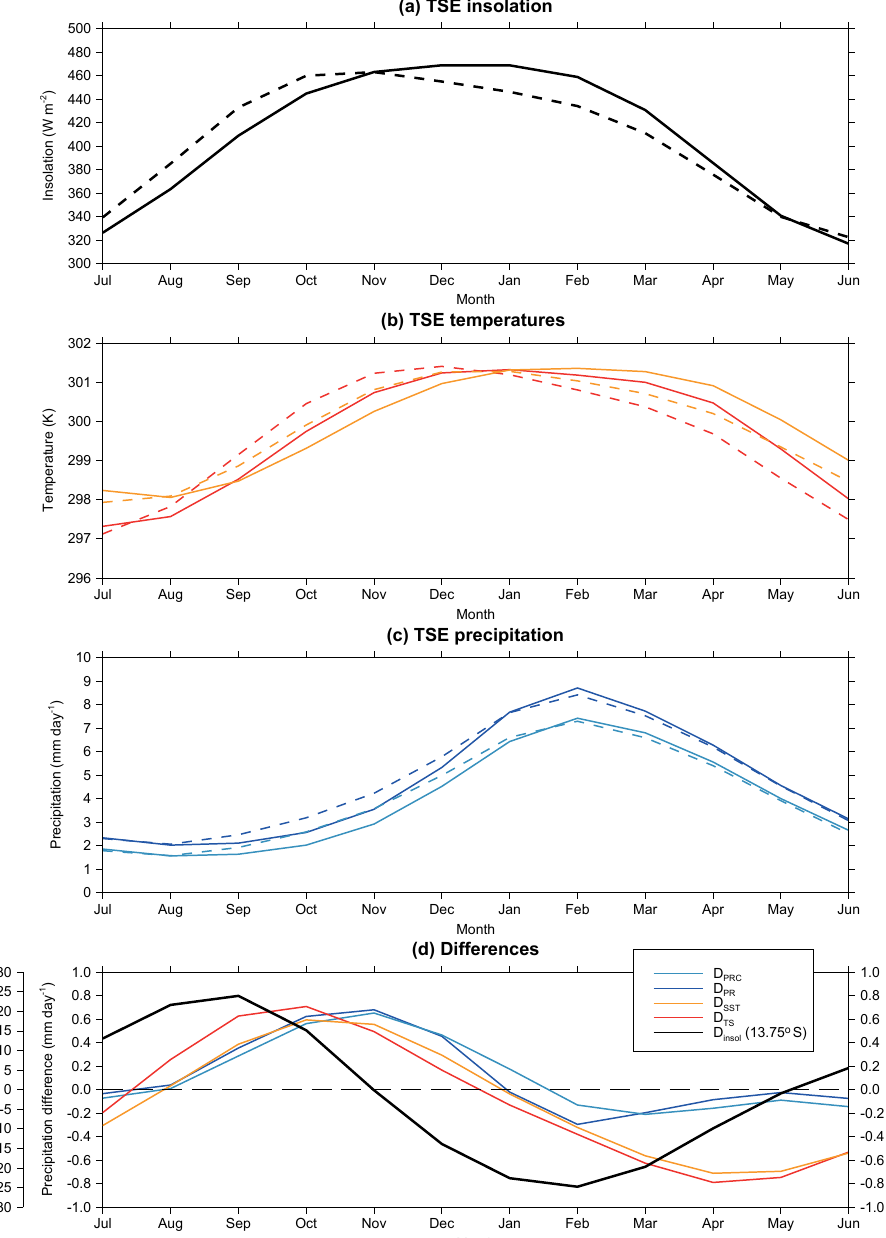
Figure 8. The monthly, ensemble and regional mean (a) insolation (taken at 13.75 ◦ S for insolation, black line, Wm − 2 ), (b) surface tem- perature (land and ocean combined, red line, K) and sea surface temperature (when available, amber line, K) and (c) total precipitation (blue line, mmday − 1 ) and convective precipitation (turquoise line, mmday − 1 ) at 0ka (solid lines) and 6ka (dashed lines) within the TSE box. The difference in those fields (insolation, temperature and precipitation) for 6 − 0ka is plotted in (d) .